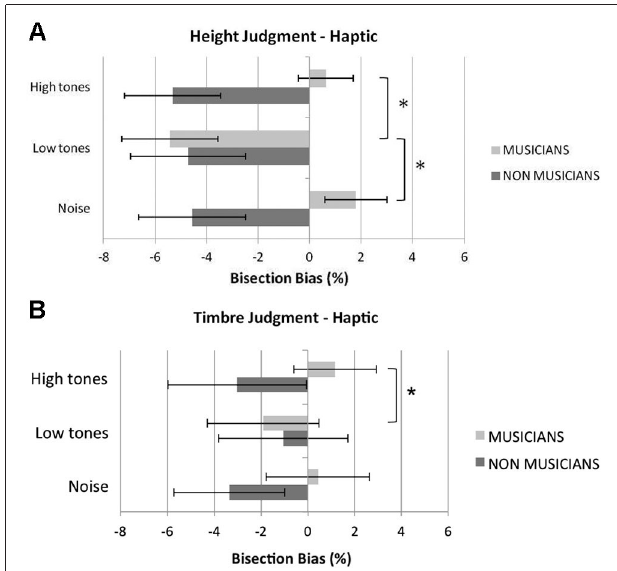
FIGURE 3 | Mean percentage haptic bisection bias in the height (A) and in the timbre (B) judgment tasks in bisecting rods in the control (white noise), low tones and high tones conditions. Overall, listening to low tones shifted musicians’ bisection significantly to the left compared to listening to white noise or high tones. Pitch of the tones did not affect non musicians’ performance. Error bars represent ± 1 SEM. Asterisks indicate significant differences between task